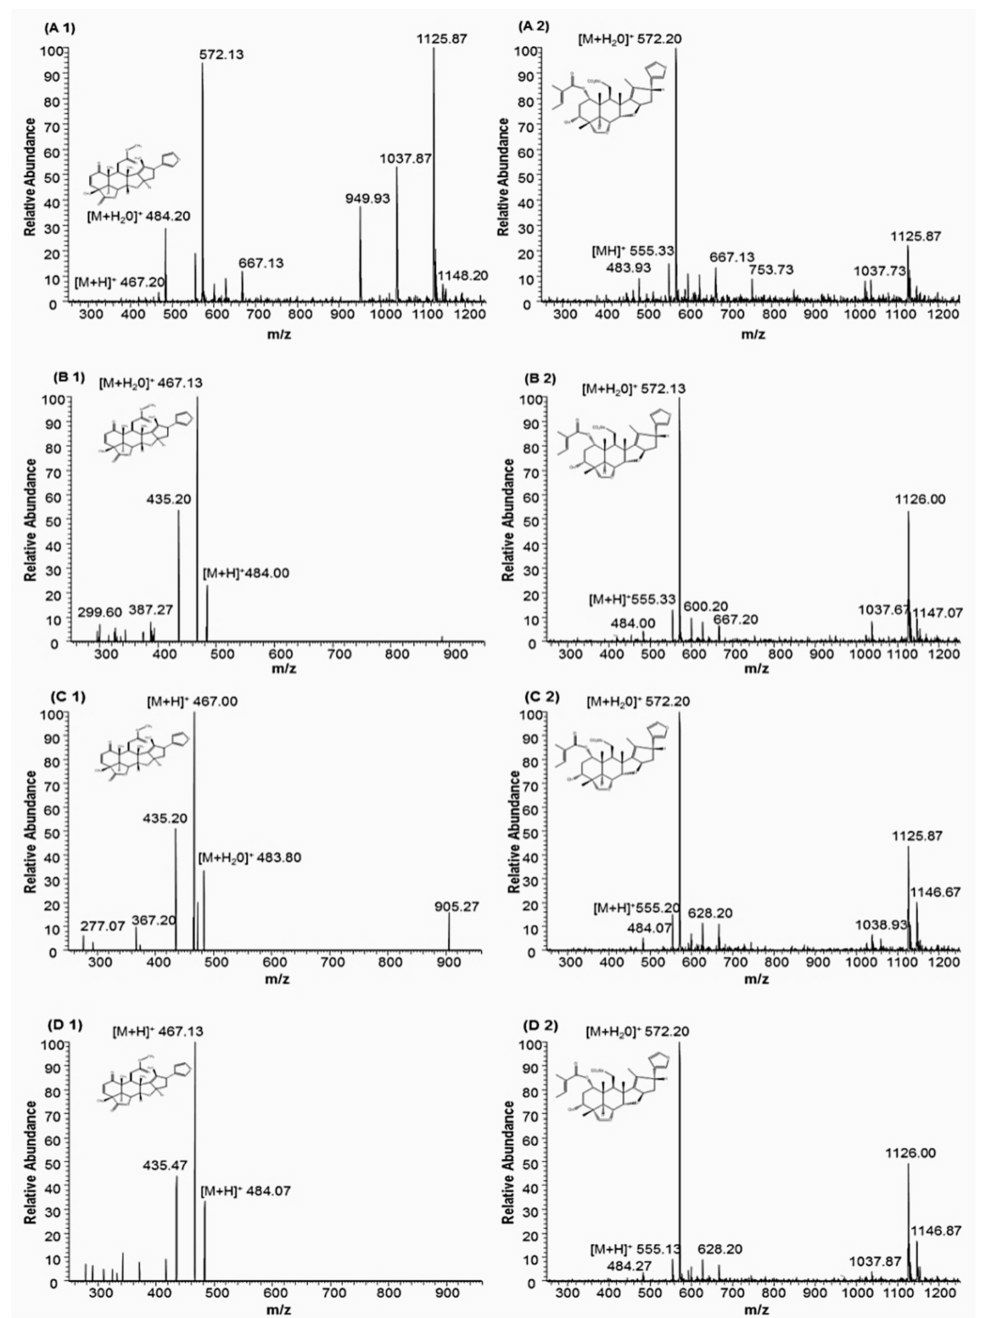
Figure 2. Mass spectra of nimbolide ( A1 , B1 , C1 , and D1 ) and 3-Deacetylsalannin ( A2 , B2 , C2 , and D2 ) terpenoids extracted by pressurized liquid extraction. Capital letters A, B, C, and D correspond to SH, SEA, SE, and EE,